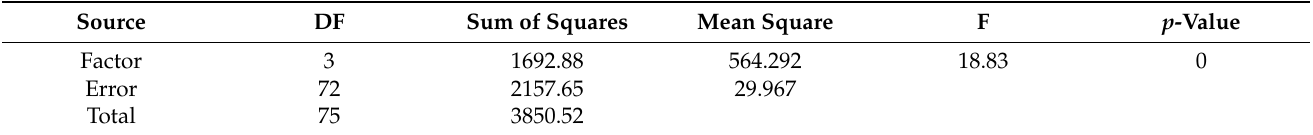
Table 5. ANOVA for ARPD of the four compared